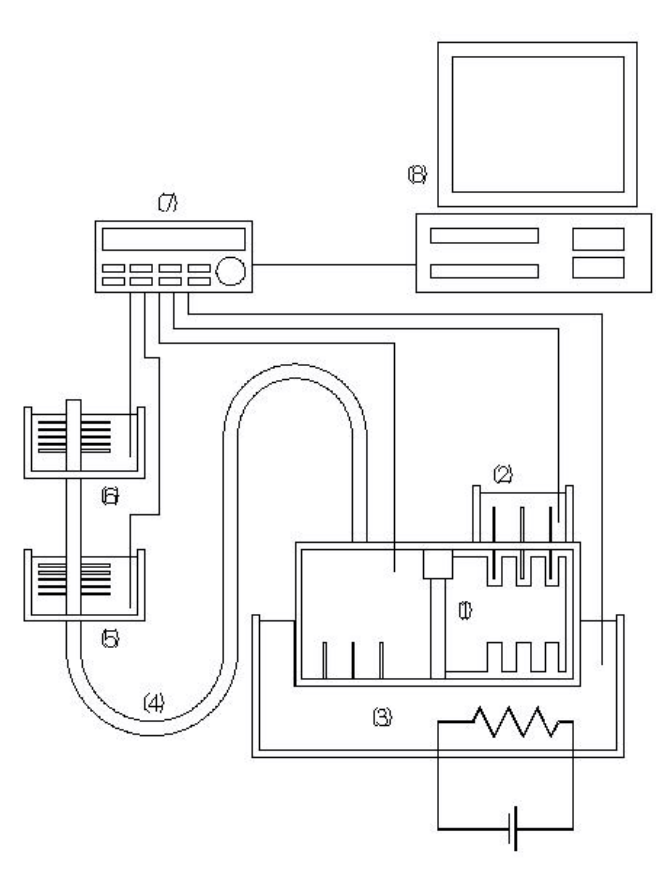
Figure 8. Experimental settings and system components arrangement.